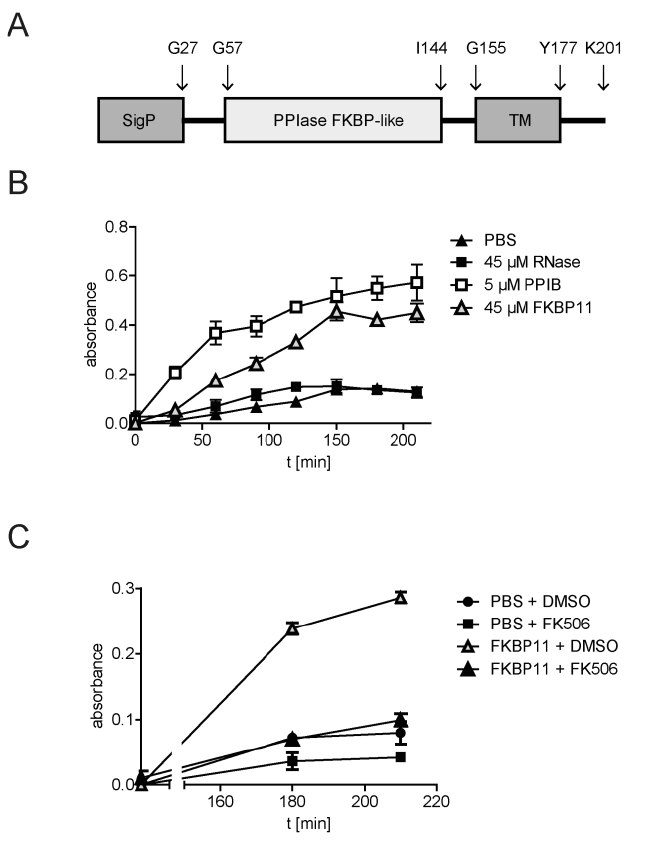
Figure 5. Recombinant FKBP11 folds IgG antibody in vitro. ( A ) Schematic representation of FKBP11 domain structure. For these experiments, the purified FKBP domain of FKBP11 (amino acids G28 - A146) without the N-terminal signal peptide (SigP) and the C-terminal transmembrane region (TM) was used. ( B ) In vitro antibody refolding kinetics in absence and presence of FKBP11 and recombinant PPIB as positive control. ( C ) Antibody refolding by FKBP11 was inhibited by tacrolimus (FK506). Data shown is based on three independent experiments and given as mean ± SEM; error bars are missing when they were smaller than the size of the data symbols.